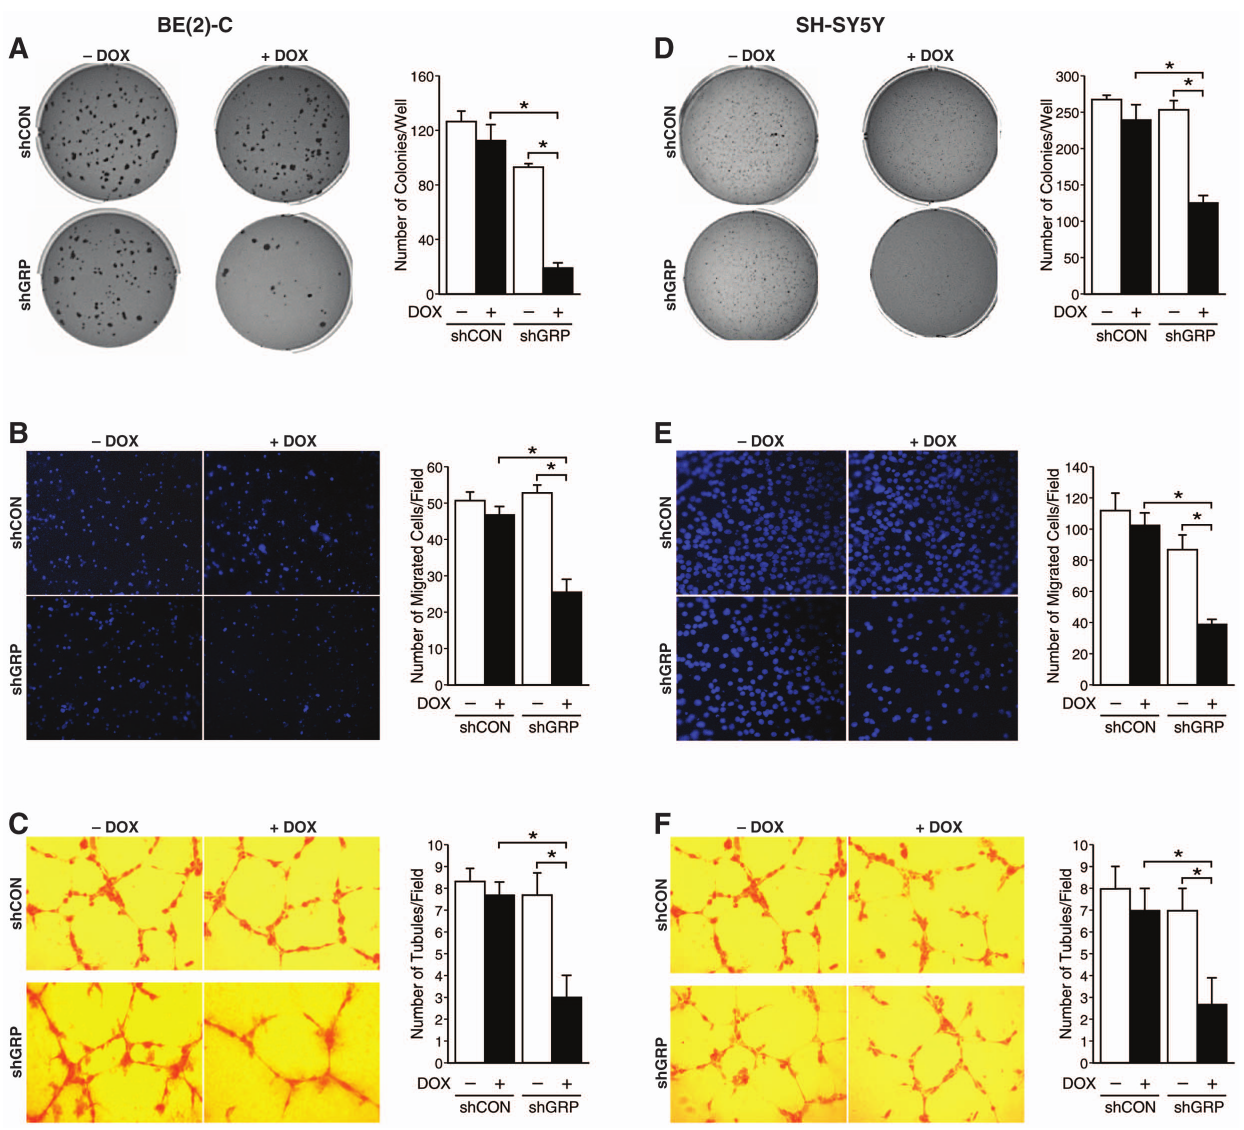
Figure 1. Targeted GRP silencing inhibited neuroblastoma progression. (A, D) BE (2)-C/Tet/shGRP ( + DOX) cells and SH-SY5Y/Tet/shGRP ( + DOX) cells, respectively, demonstrated a decrease in soft agar colony formation in comparison to Tet/shGRP (-DOX) cells or Tet/shCON ( + DOX) cells. (B, E) GRP silencing in BE (2)-C/Tet/shGRP ( + DOX) and SH-SY5Y/Tet/shGRP ( + DOX) cells, respectively, decreased cell migration in a transwell assay in comparison to controls. (C, F) HUVECs cultured in cell culture supernatant from GRP silenced cells resulted in decreased tubule formation than when grown in supernatant from control cells (mean 6 SEM; *= p , 0.05).